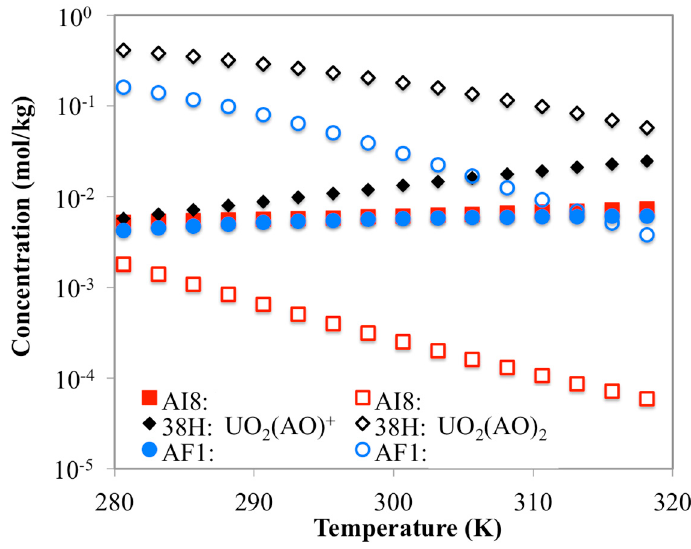
Figure 10. Simulated concentrations for UO 2 (AO) + (filled shapes) and UO 2 (AO) 2 (hollow shapes) for all three materials. While simulations with AF160 and 38H materials have shown UO 2 (AO) 2 to be dominant, these results indicate that the AI8 material has UO 2 (AO) + as the dominant uranyl-AO